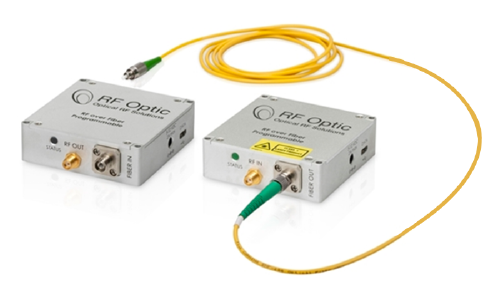
Figure 5. RF Optic [27].